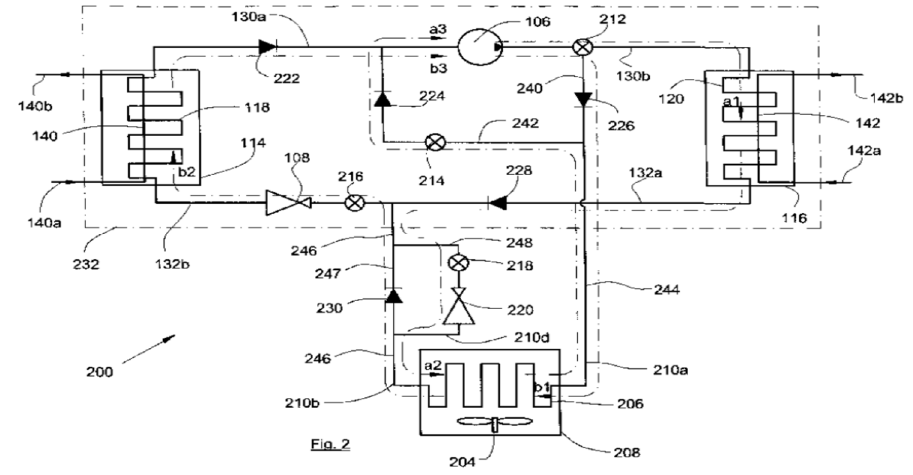
Figure 21. Schematic diagram of the patent of Climatik Sarl (FR2886388-2005).